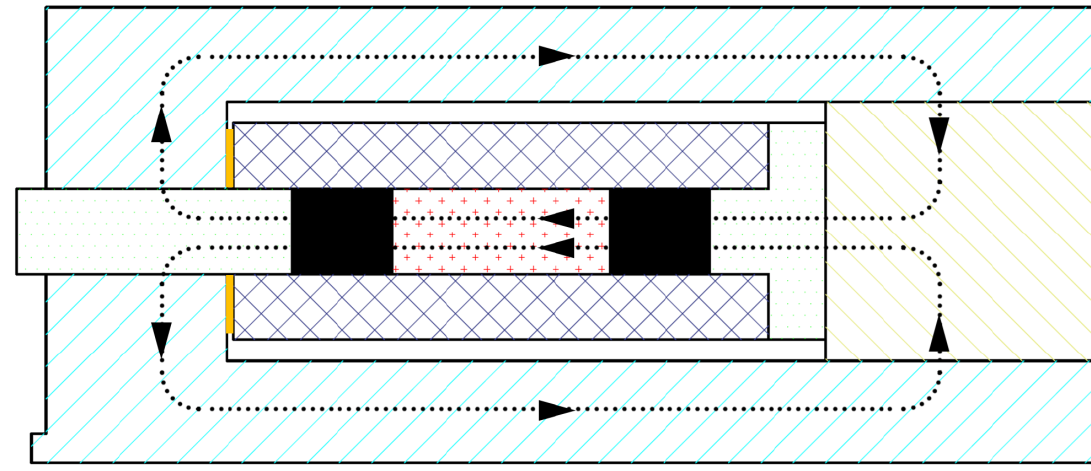
Figure 4. Direction of magnetic circuit.